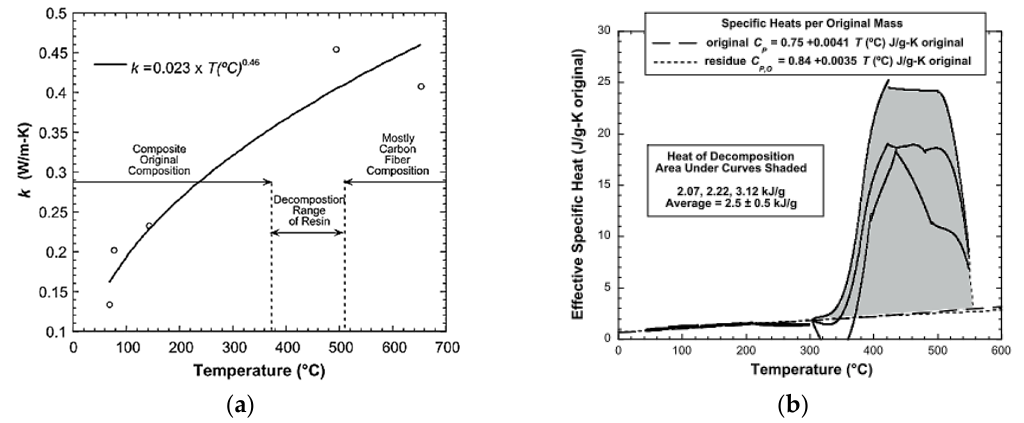
Figure 2. ( a ) Thermal conductivity versus temperature; and ( b ) specific heat capacity versus temperature and heat of decomposition of a carbon fibre/epoxy composite [19].